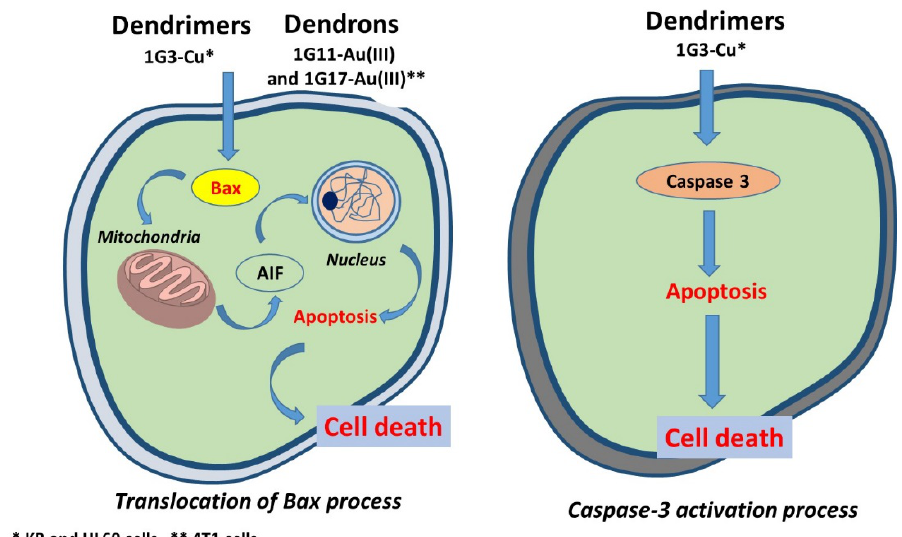
Figure 6. General view of the cell death pathway of phosphorus dendrons in comparison with the corresponding dendrimers. corresponding